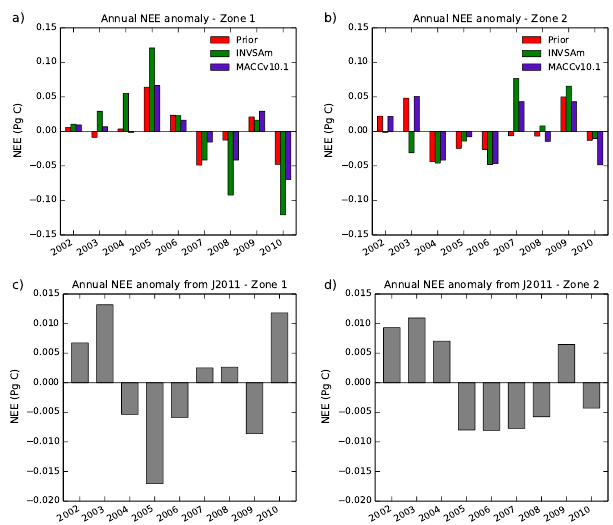
Figure 10. Annual NEE anomaly compared to the 2002–2010 mean for Zone 1 (a, c) and Zone 2 (b, d) as defined in Fig. 8. Estimates from prior fluxes (red), INVSAm (green), MACCv10.1 (purple) and J2011